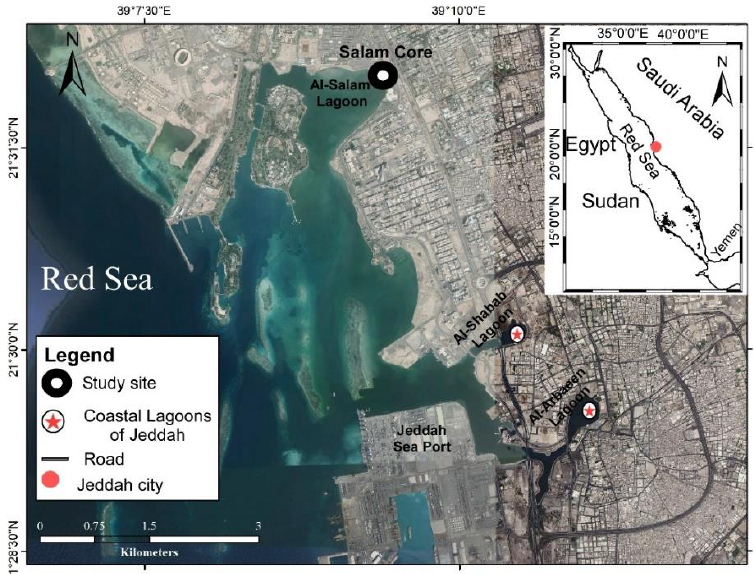
Figure 1. Location map of sediment core Salam1 and coastal lagoons of the Jeddah city, Saudi Ara- bia.